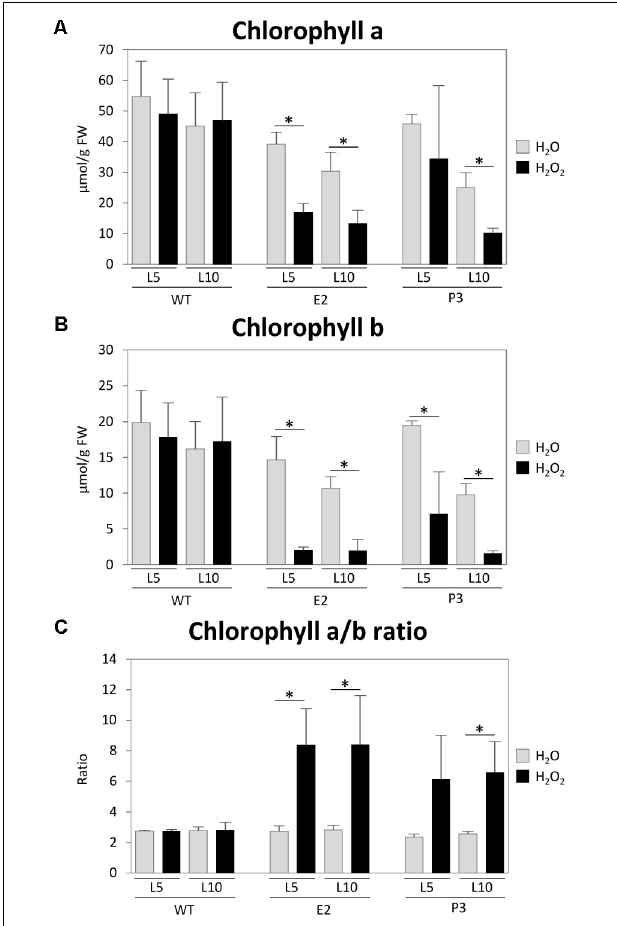
FIGURE 6 | H 2 O 2 treatment experiment. Small leaf disks from leaves (L5 and L10) were treated with a 1 M H 2 O 2 solution for 3 days. Chlorophyll contents (A,B) were measured and the ratio (C) was determined and compared with those of water treated plants. Data represent the mean ( ± SD) of three biological replicates. Differences between the H 2 O 2 /water treated plants were analyzed using Student’s t -test and statistical significance was indicated ( ∗ P <